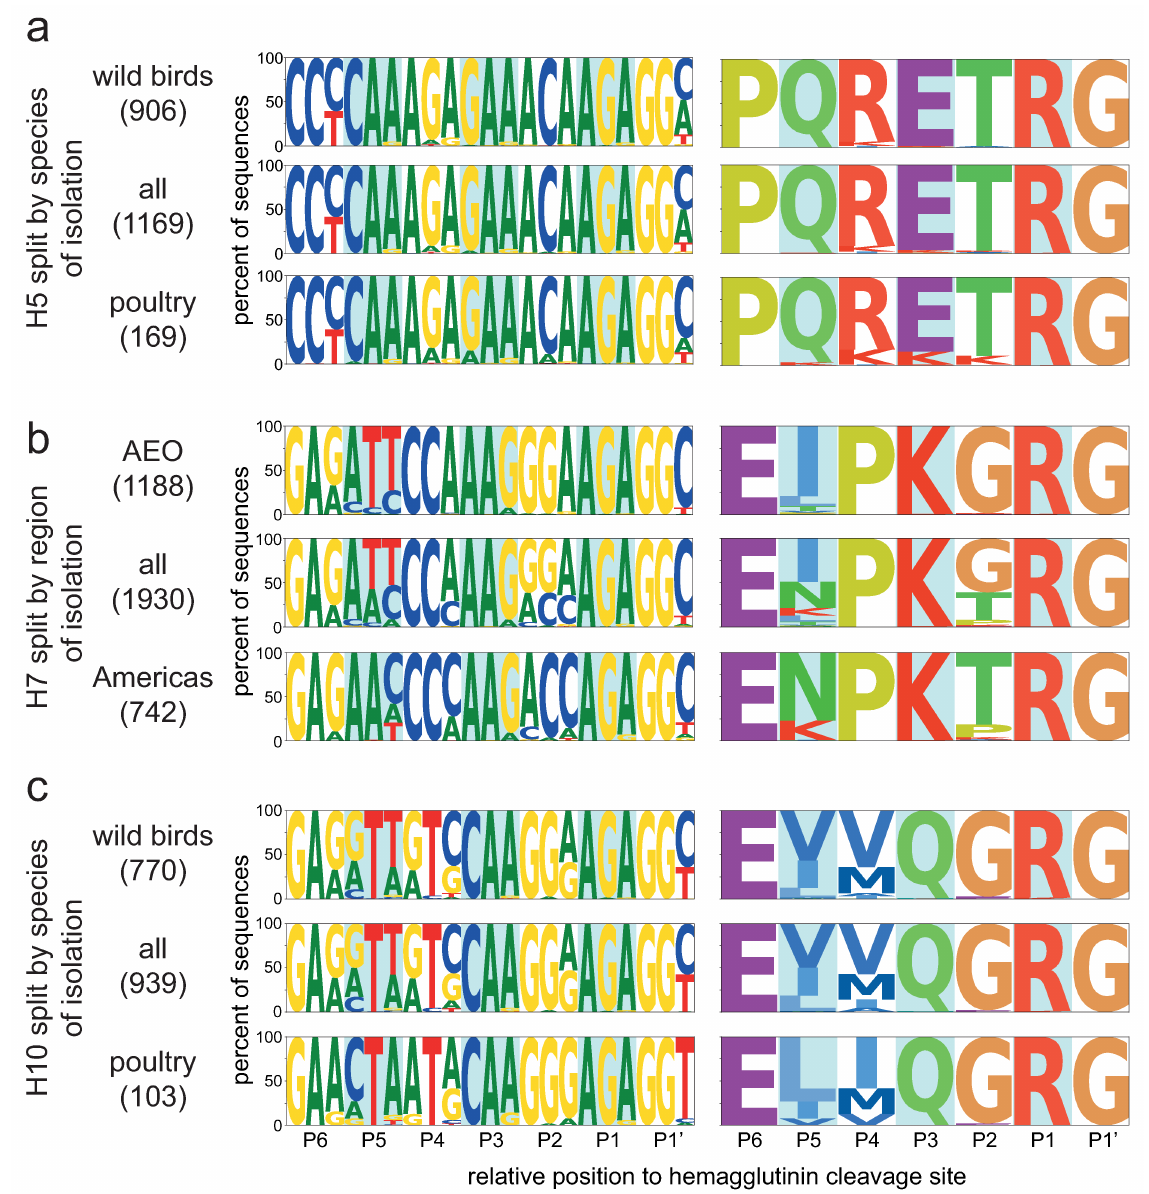
Figure 3. Examples of species- or region-specific codon usage observed in H5, H7, and H10 sequences. ( a ) Sequence logos of sequences from H5 viruses isolated from wild aquatic birds (wild birds), terrestrial poultry (poultry), or all species combined (including 94 sequences from other or not determined species), shown for nucleotide (left) and amino acid (right) sequences. The number of sequences used to generate the logos is indicated in brackets. ( b ) Sequence logos of sequences from H7 viruses isolated in the Americas, the AEO region, or both combined, using the same representation as in ( a ). ( c ) Sequence logos of sequences from H10 viruses isolated from wild aquatic birds (wild birds), terrestrial poultry (poultry), or all species combined (including 66 sequences from other or not determined species), using the same representation as in ( a